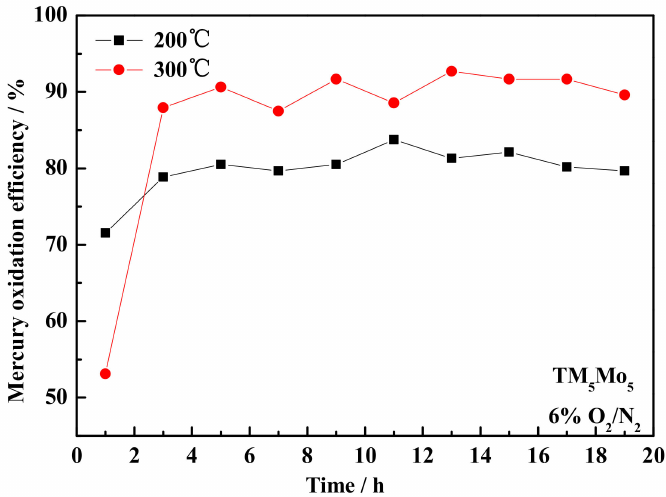
Figure 8. Long time test of the mercury oxidation over TM 5 Mo 5 at 200 and 300 ◦ C.